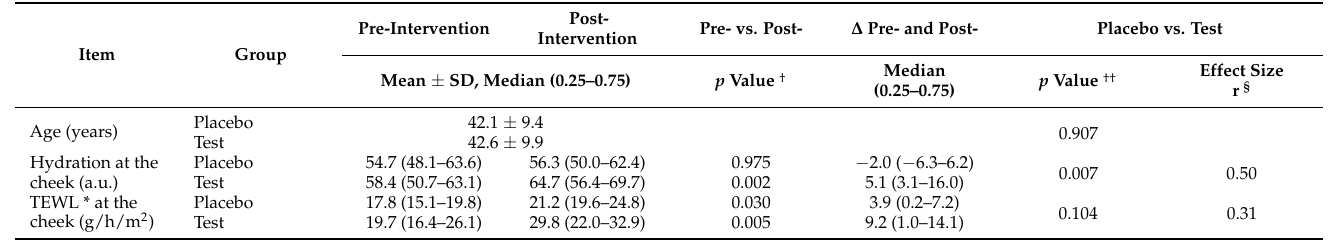
Table 6. Comparisonsof itemsbetweentheplacebo group andthetest groupin total28female